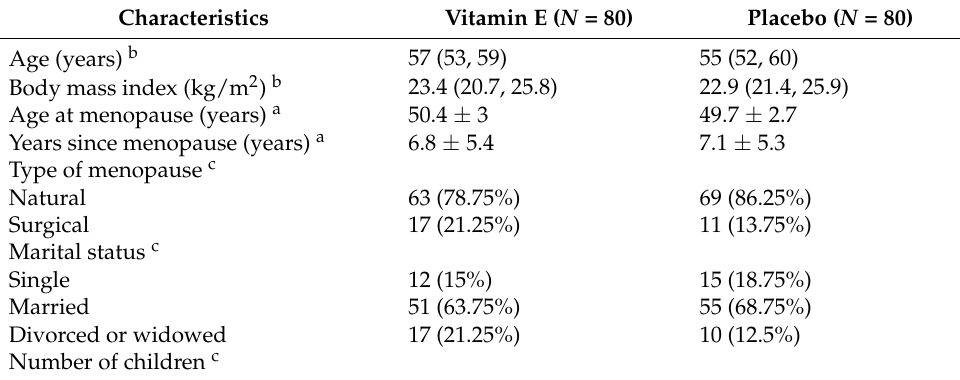
Table 1. Baseline characteristics of the